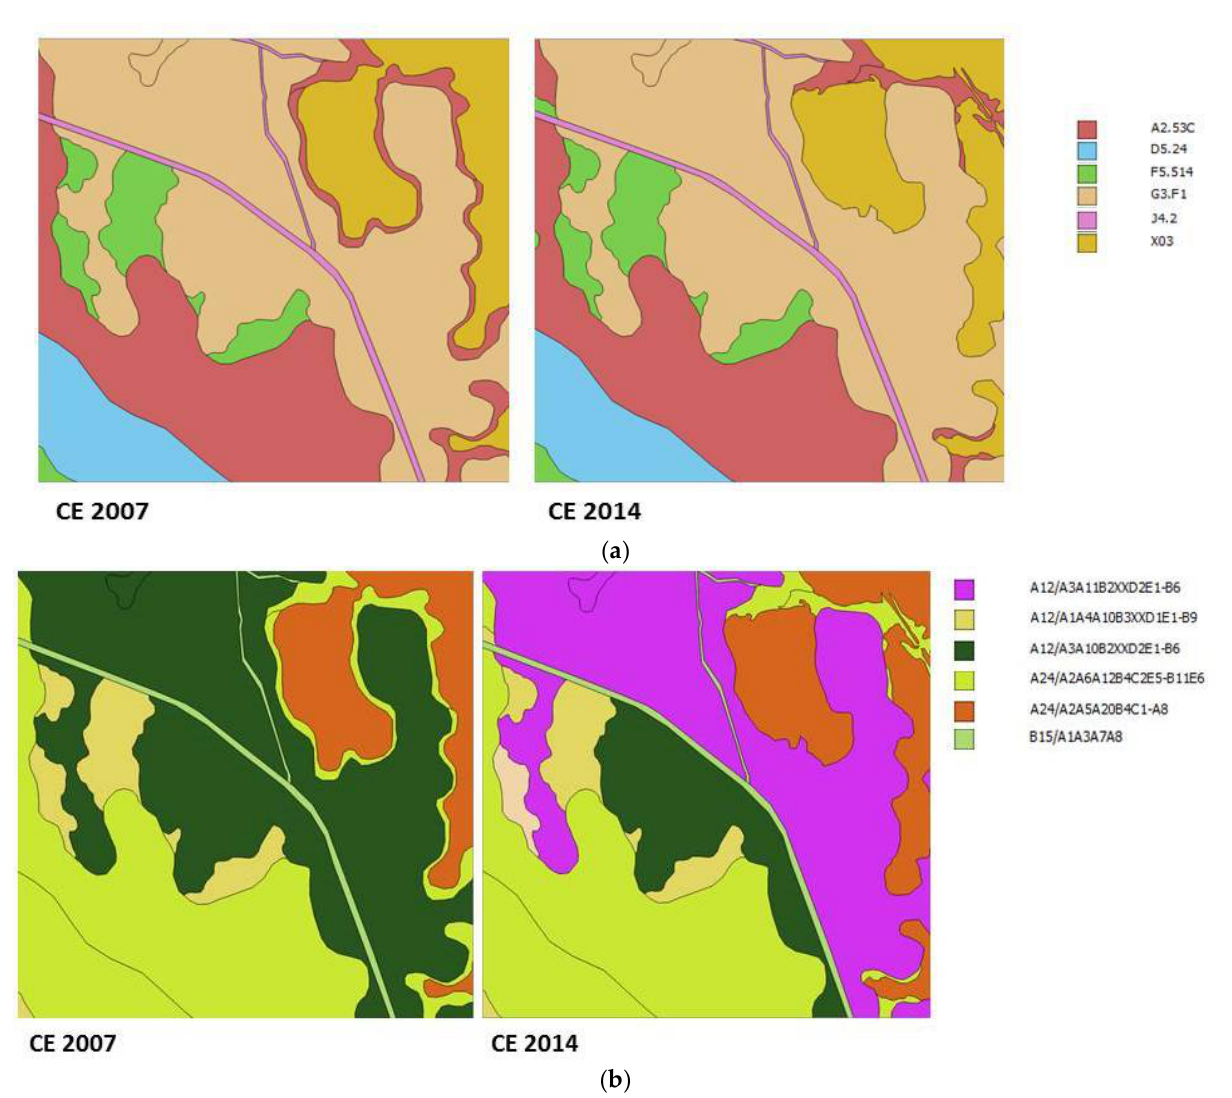
Figure 18. Changes in cover were observed in the pine woods in the CE site, where the canopy cover decreased over time. ( a ) The same EUNIS type, G3.F1 (native conifer plantations) was used in 2007 and in 2014; ( b ) the cover change of some areas is well represented with LCCS, changing from A12/A3.A10.B2.XX.D2.E1-B6 (Needleleaved evergreen medium high closed trees) to A12/A3.A11.B2.XX.D2.E1-B6 (Needleleaved evergreen woodland).